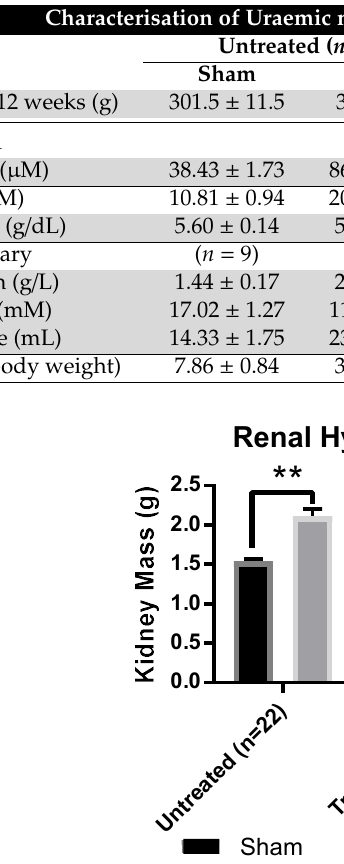
Table 1. Markers of renal function in sham and uraemic animals with and without iv iron. Data are presented as mean ± SEM. GFR (glomerular filtration rate) * p < 0.05; sham versus uraemic; } p < 0.05; uraemic untreated versus treated.